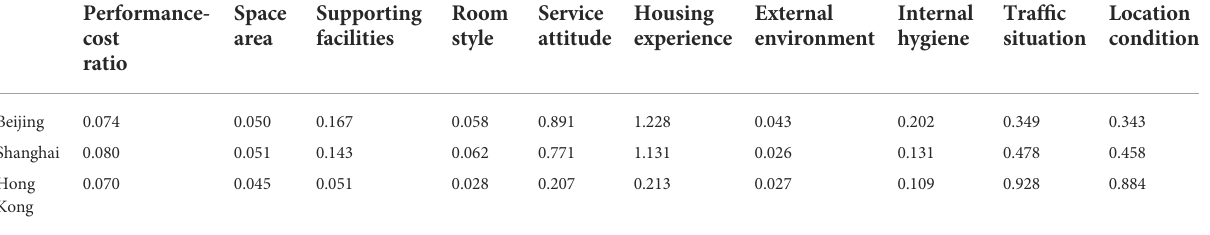
TABLE 13 Comparison of emotional characteristics of green users in Beijing, Shanghai and Hong Kong (I).